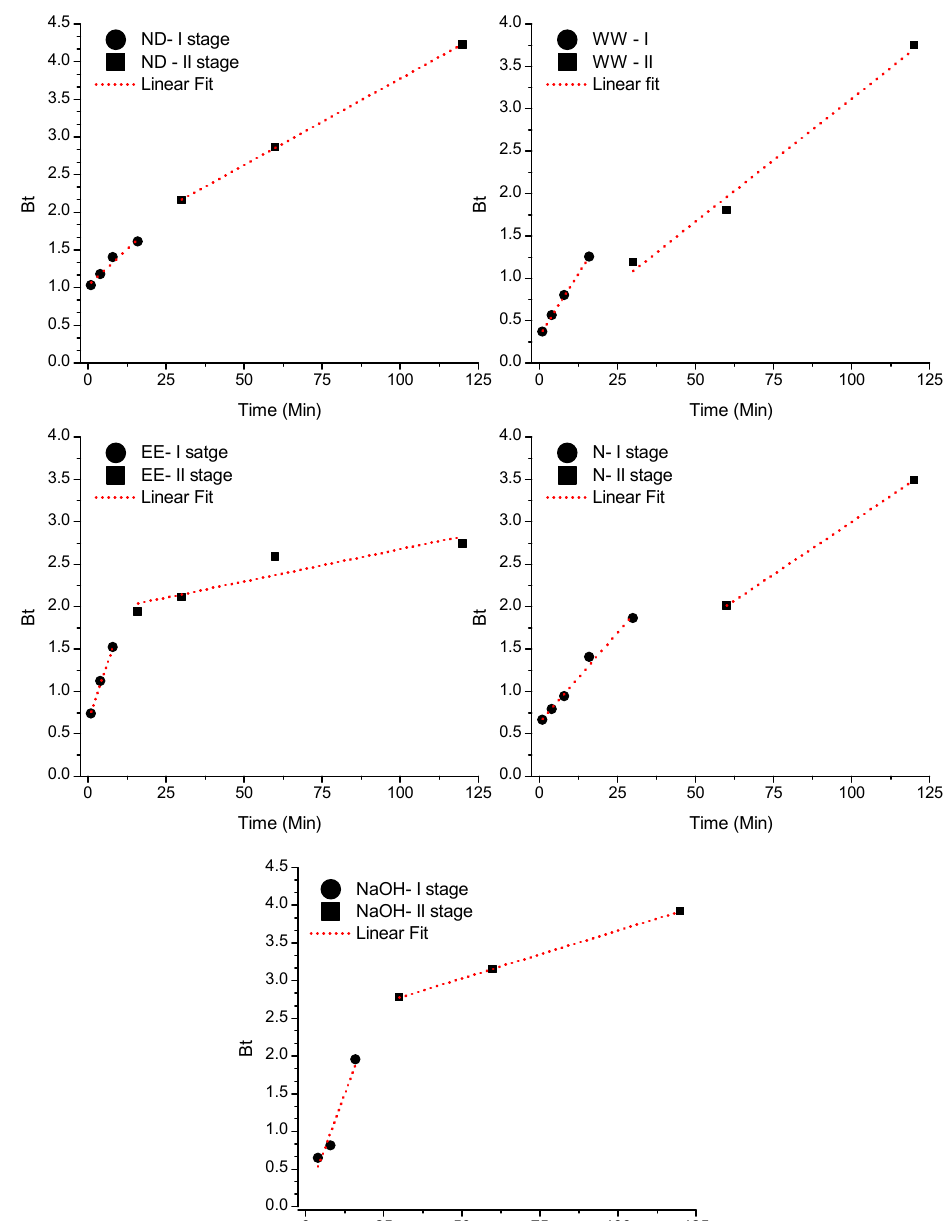
Figure 2. Plot Bt × Time by the Boyd linear regression diffusion model for five adsorbents tested to remove Pb(II) ions.